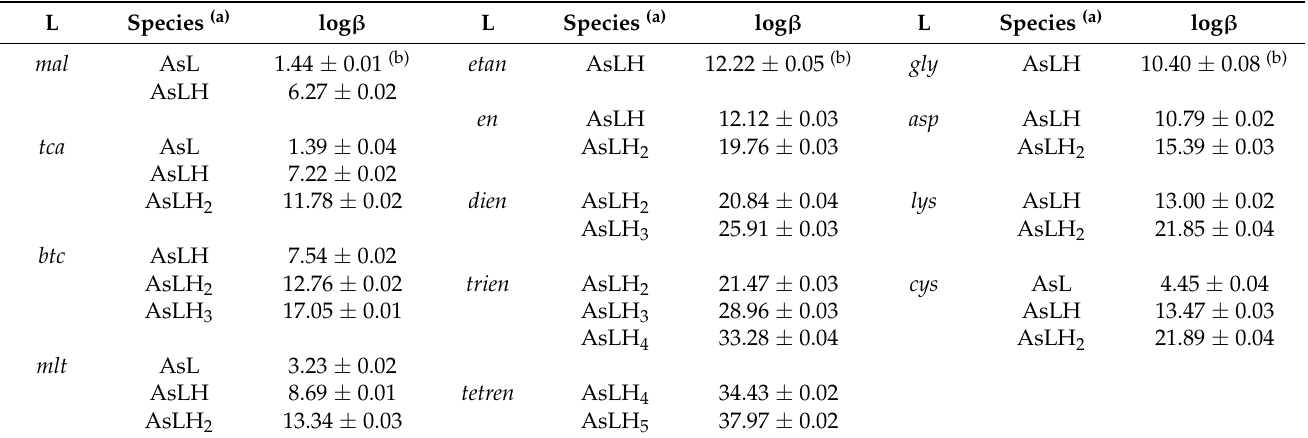
Table 1. Overall stability constants for As(III)–ligand systems in NaCl at I = 0.15 mol/L and T = 298.15